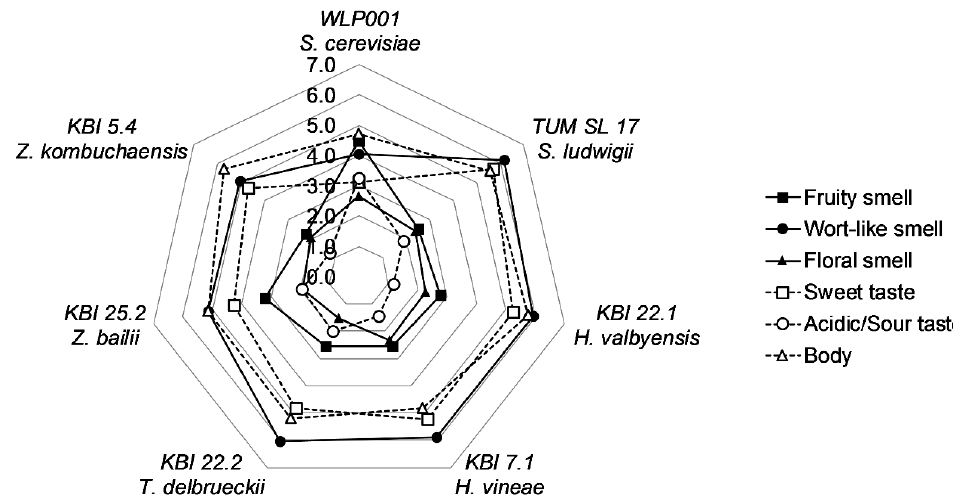
Figure 4. Spider web of the means of the descriptors from the sensory of the final